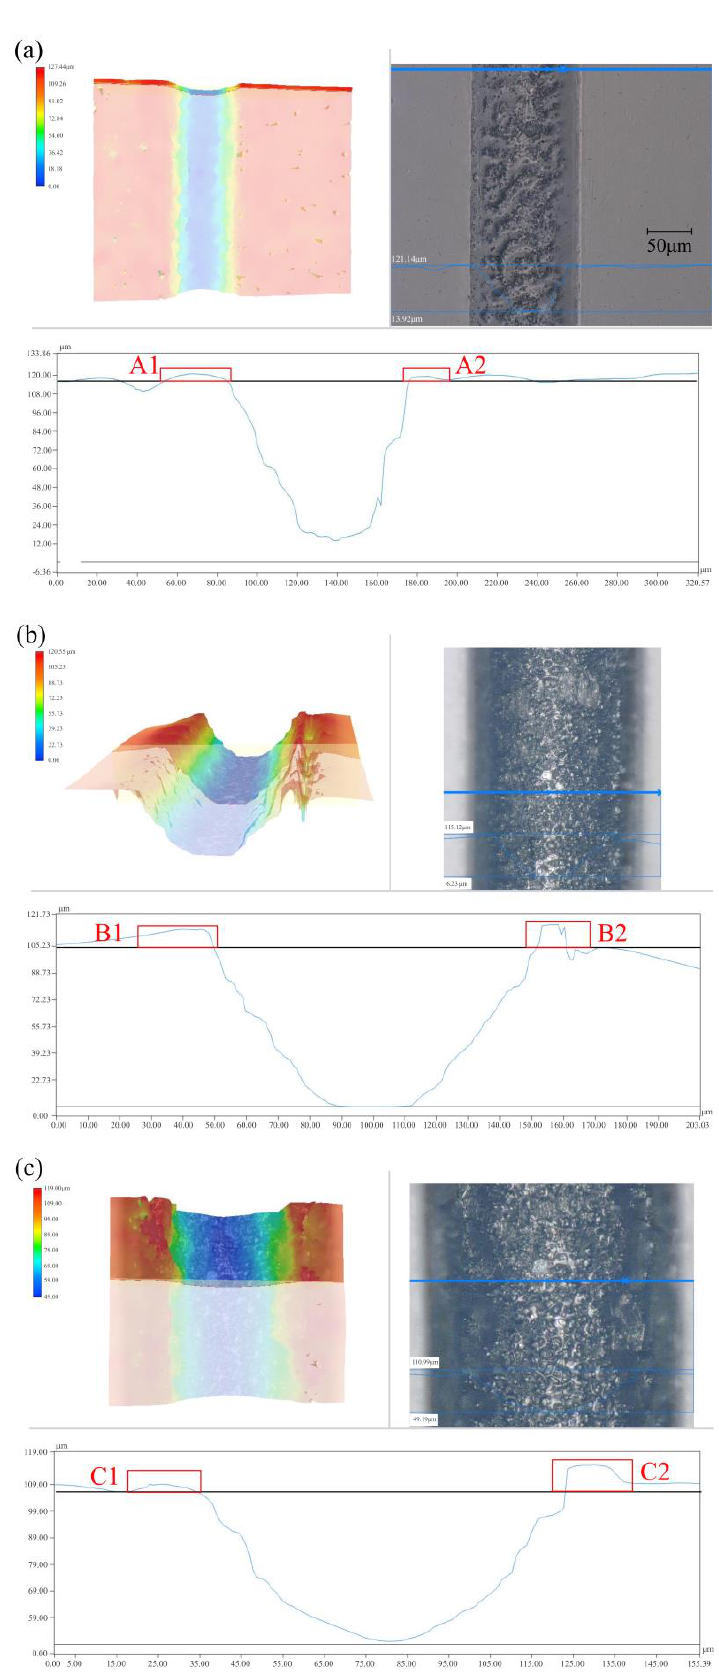
Figure 13. Microstructure topography and cross section of trapezoidal groove structures ( × 1000): ( a ) sample 1-3, ( b ) sample 1-4 and ( c ) sample 1-6.